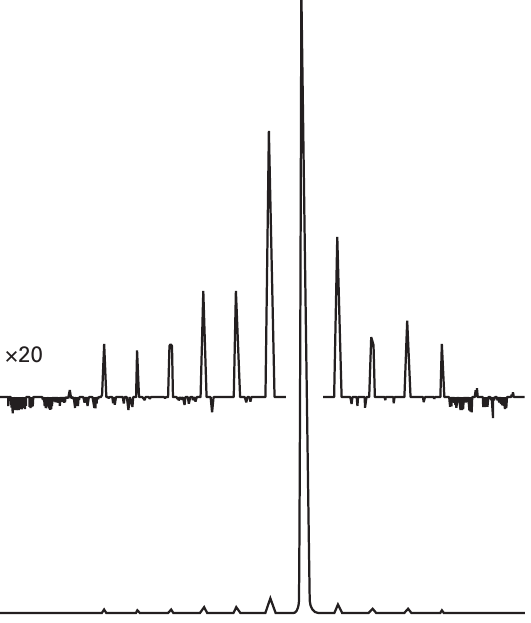
Figure 7. Measured spectral output of the device shown in Figure 6. Wavelength is along the abscissa and power is along the ordinate. Adapted with permission from Figure 6 of [30] ©The Optical